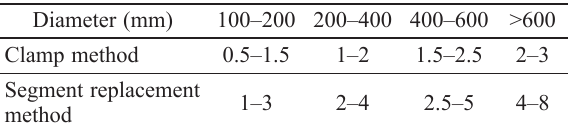
Table 3. Pipe repair times (hr)